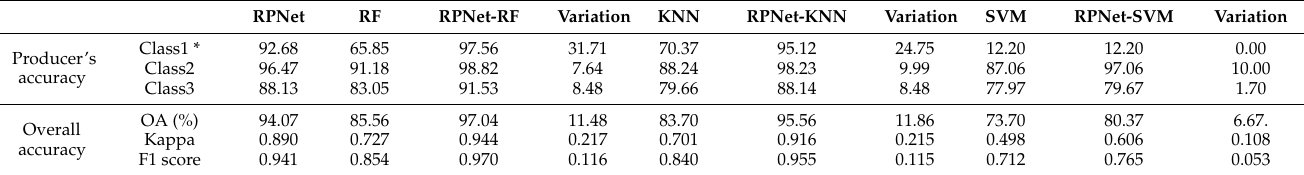
Table 5. Comparison of accuracies of traditional methods and decision fusion methods